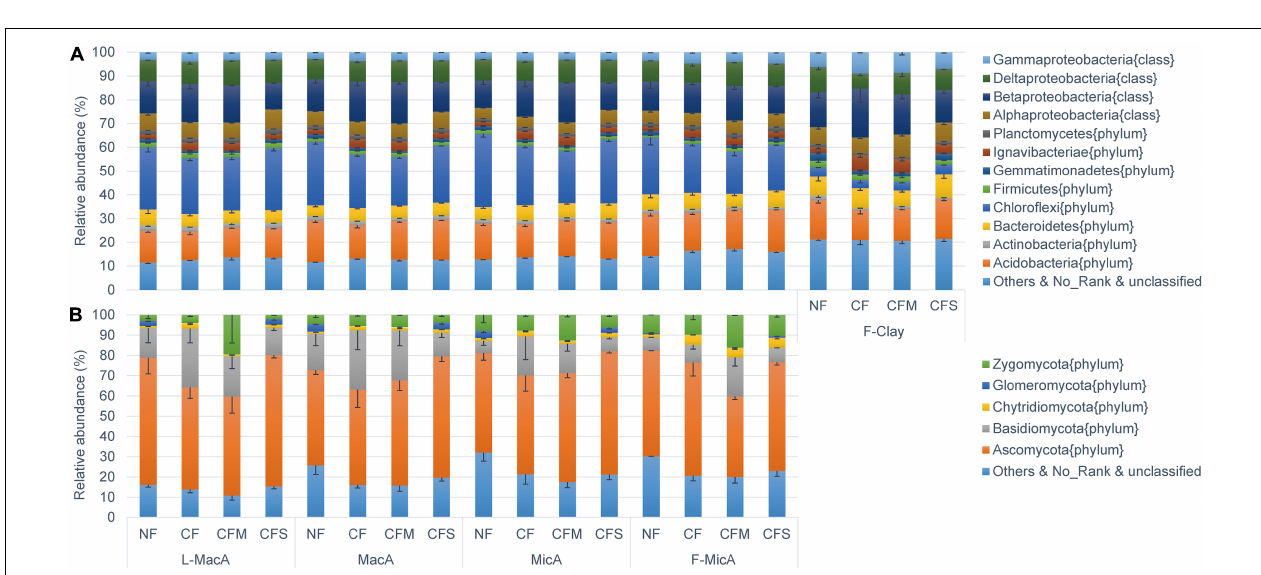
FIGURE 2 | Average relative abundance distribution of V4–V5 16S rDNA sequence classified at phylum level (class for Proteobacteria) for bacteria (A) and ITS1-ITS2 sequence classified at phylum level for fungi (B) . Error bars represent the standard errors. Average proportions of showed bacterial phyla (class for Proteobacteria) and fungal phyla all exceed 1%. NF, no fertilizer applied; CF, compound inorganic fertilizer; CFM, inorganic fertilizer combined with swine manure; CFS, inorganic fertilizer combined with residue return. L-MacA, > 2,000 µ m; MacA, 2,000–250 µ m; MicA, 250–53 µ m; F-MicA, 53–2 µ m; F-Clay, < 2 µ m.